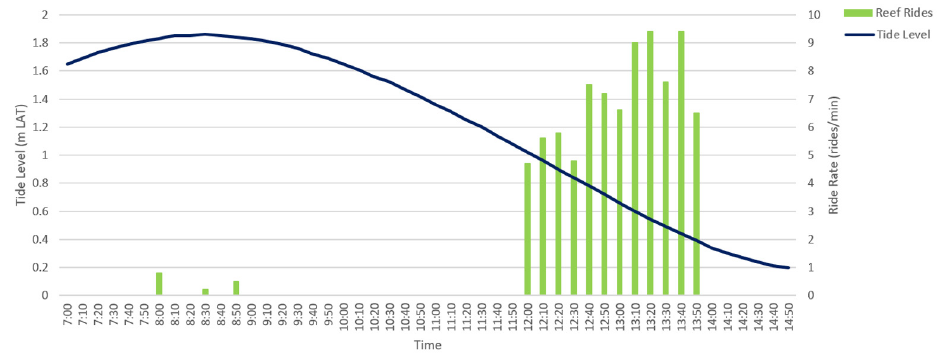
Figure 9. Tide level vs. ride rates over the reef (8–9 a.m. and 12–2 p.m. only).